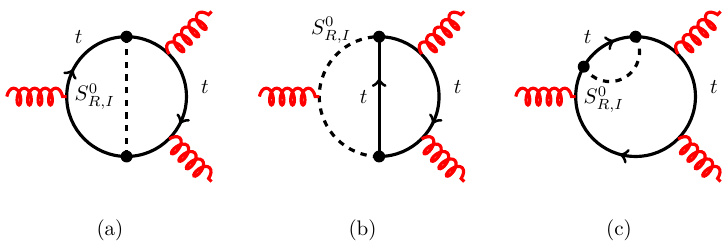
Figure 5 . Neutral scalar contributions to the Weinberg operator. The colour structure of diagram (a) yields a suppression factor of 1 / 6 with respect to a THDM with colour-singlet scalars. In turn, diagram (b) is specific to colour-octet scalars, and diagram (c) vanishes.